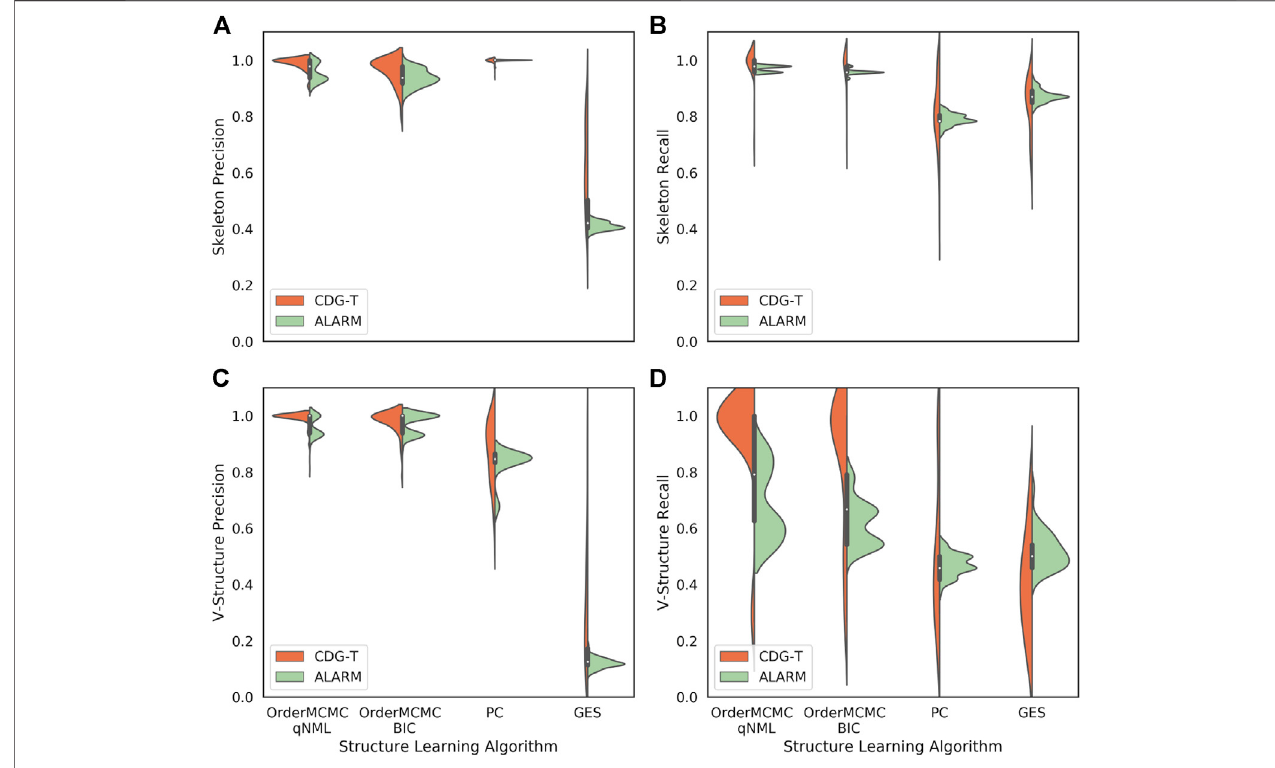
FIGURE 8 | The performance obtained on CDG-T datasets vs. the ALARM dataset over 100 runs. (A) : Skeleton Precision; (B) : Skeleton Recall; (C) : V-structure Precision; (D) : V-structure Recall. There is a general alignment on the skeleton estimates, but V-Structure Recall is overestimated for the OrderMCMC methods.